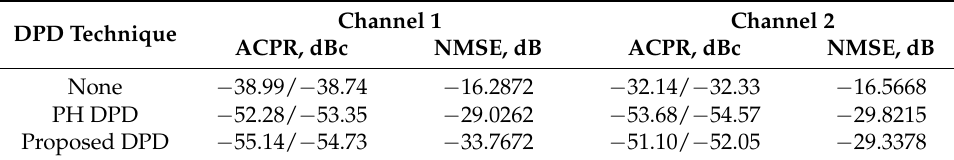
Table 2. DPD results for different models in 2 × 1 MIMO transmitters for LTE 20MHz signal in case 2 ( K = 7, M = 3).